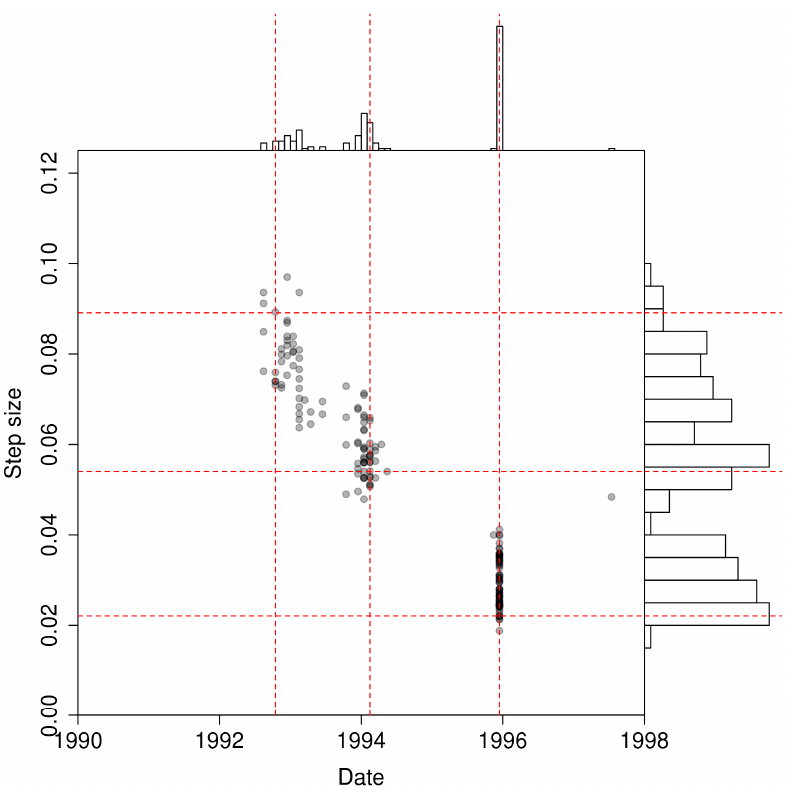
Figure 5. Scatter plot and histograms of the change point date versus step size for the GTMBA ensemble members where 1 change point was detected. Also shown are the median and 95% confidence intervals for the date and step size (red dashed lines).